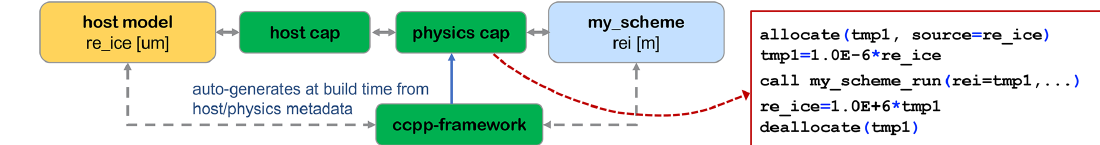
Figure 3. Example for automatic unit conversions in the auto-generated physics